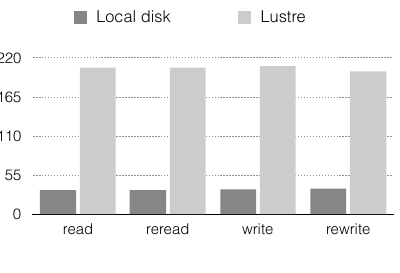
Figure 3. DFSIO benchmark results for reading and writing to a Hadoop cluster. Results are in minutes to complete the benchmark. Shorter time indicates better performance. Lustre (light gray) is consis- tently better than local disks (dark